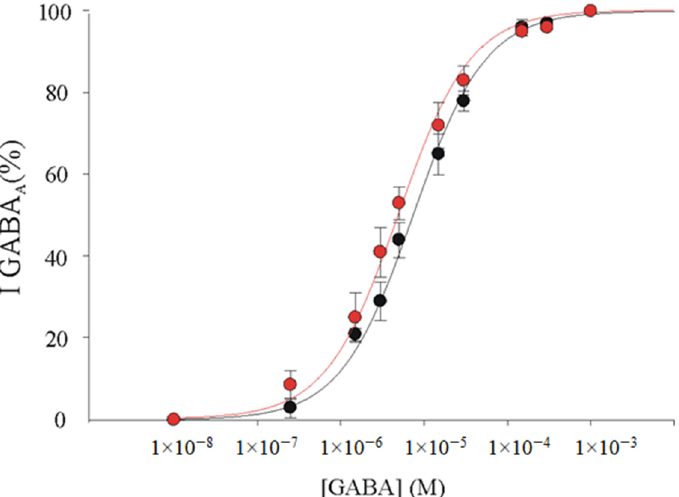
Figure 4. GABA A Rs affinity in oocytes expressing α 1 β 2 γ 2 GABA A Rs or α 1 β 2 GABA A Rs. GABA dose–current relationships in oocytes injected with α 1 β 2 γ 2 ( ● ) or α 1 β 2 cDNAs ( ● ). Peak currents were normalized to the current obtained with 1 mM GABA and refer to 6 oocytes each point. EC 50 and n H were 7.36 ± 0.47 μ M and 1.0 ± 0.04 for α 1 β 2 receptors; 5.0 ± 0.15 μ M and 0.99 ± 0.1 for α 1 β 2 γ 2; p > 0.05, Mann–Whitney rank sum test.